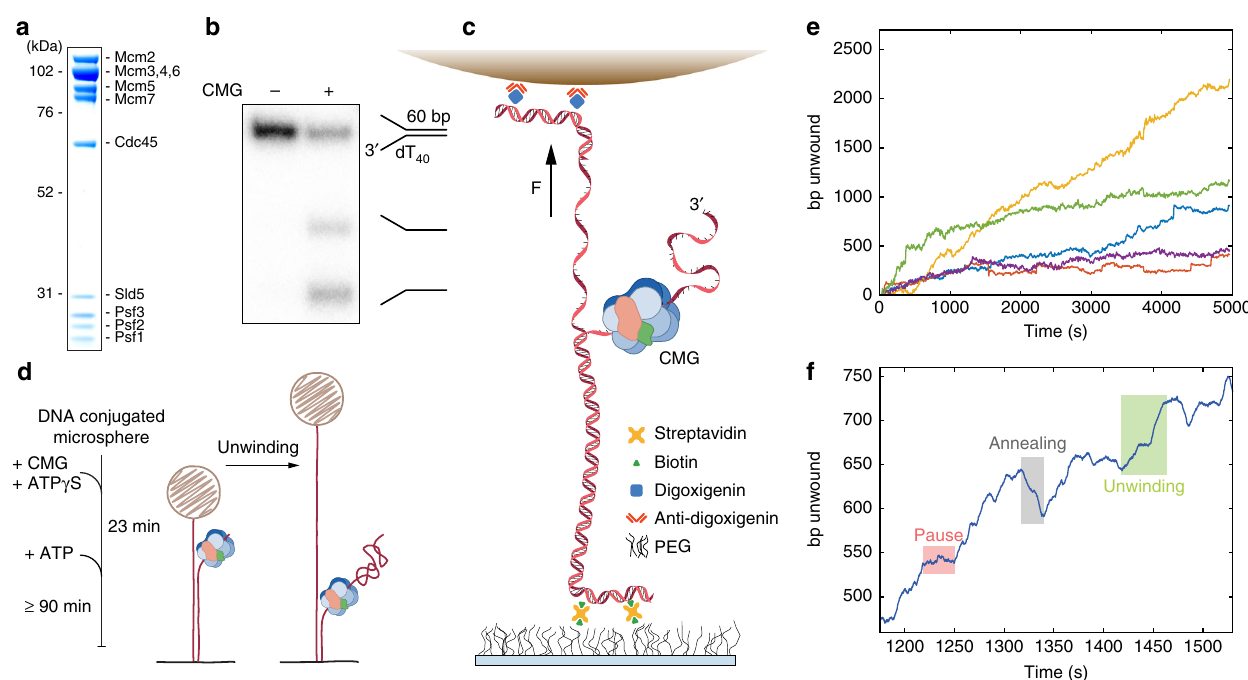
Fig. 1 Puri fi ed recombinant Dm CMG, bulk unwinding, single-molecule assay principle, and observed single-molecule DNA unwinding trajectories. a Coomassie stained 4 – 12% SDS-PAGE gel of puri fi ed Dm CMG. Sld5, Psf1-3 forms GINS. b Example of bulk unwinding of duplex DNA, radiolabelled at 5 ′ ends, by CMG. The 60 bp duplex with 40 nt 3 ′ polyT tail is unwound into the two single strands. c To form the single-molecule assay a single 2.7 kilobase dsDNA molecule, with a polyT 3 ′ overhang to serve as a high af fi nity binding site for CMG, is tethered at one end to a PEGylated glass surface via biotin and streptavidin binding; and to a super-paramagnetic microsphere at the other end via digoxigenin/anti-digoxigenin binding. A force, F , is applied using a pair of neodymium cube magnets. Precise tracking of the microsphere vertical displacement gives the extension of each single DNA molecule. d Protocol for experiment. Surface-tethered DNA is incubated with CMG in the presence of ATP γ S to aid helicase loading onto the 3 ′ ssDNA tail. ATP is then introduced through a 4 – 5 sample chamber volume wash, and unwinding begins, with data being collected for at least 90 min. e Typical examples of single- molecule DNA unwinding by CMG at 20pN and 4 mM ATP, fi ltered to 0.17 Hz using a mean running window. CMG is a slow helicase, acting non- monotonically with heterogeneity both within and between individual enzyme unwinding events. f Single-molecule unwinding CMG trajectories exhibit not only unwinding but also, what can be crudely described as, pause-like dynamics and annealing, which we attribute to reverse motion of the helicase. Example regions have been manually